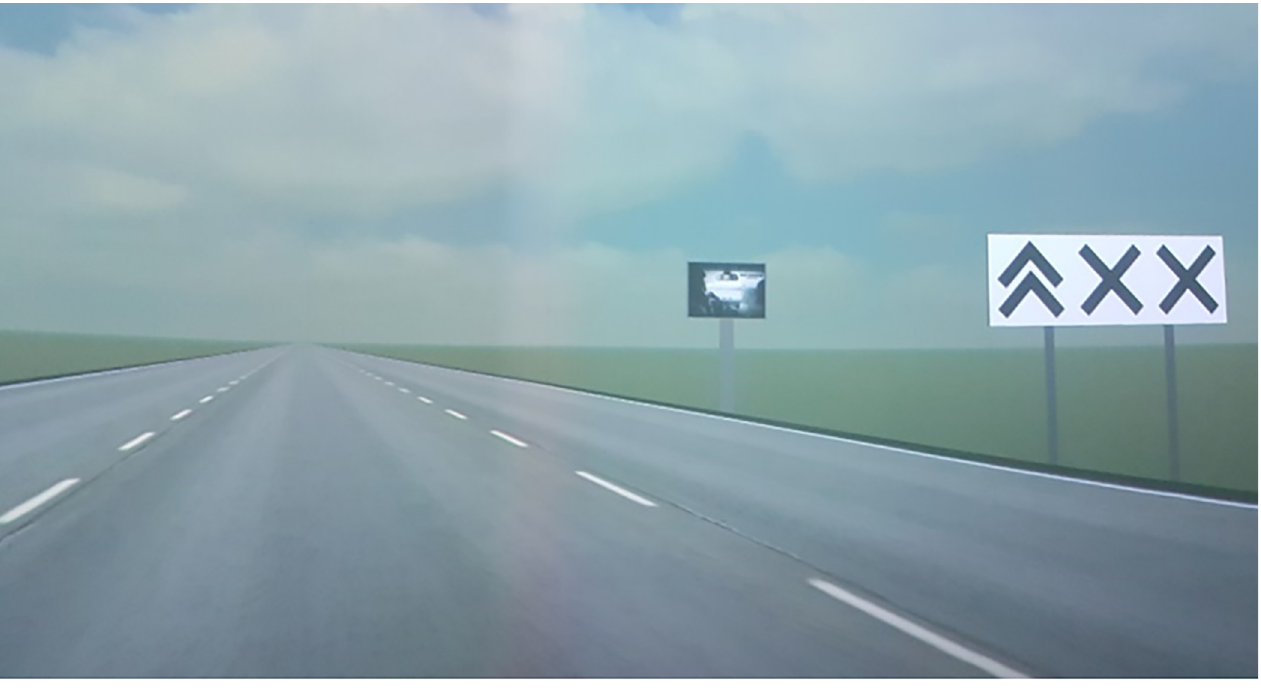
Fig 4. The modified LCT task [source: Own photo].